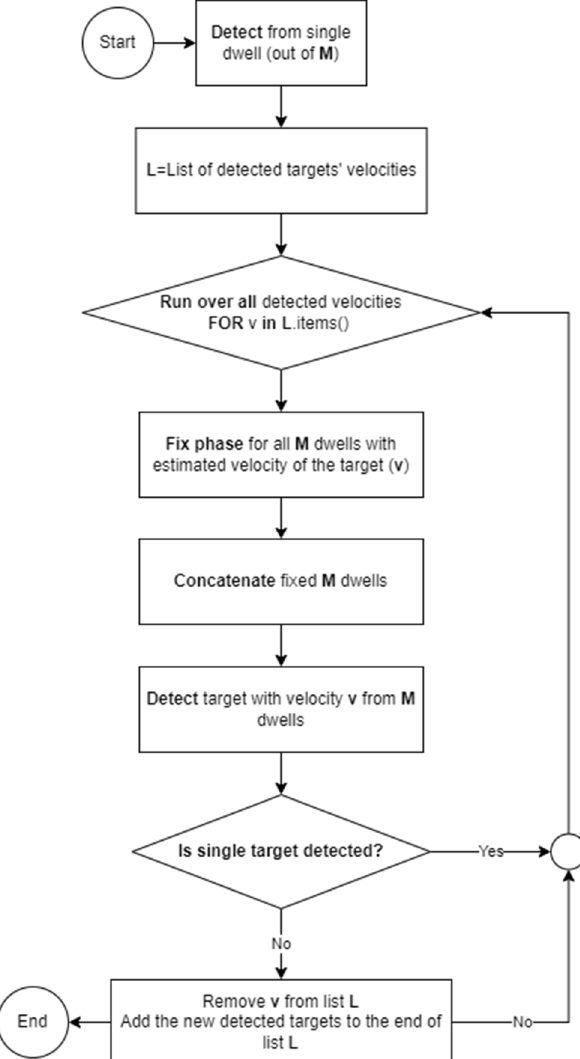
Figure 7. CMDP Algorithm.